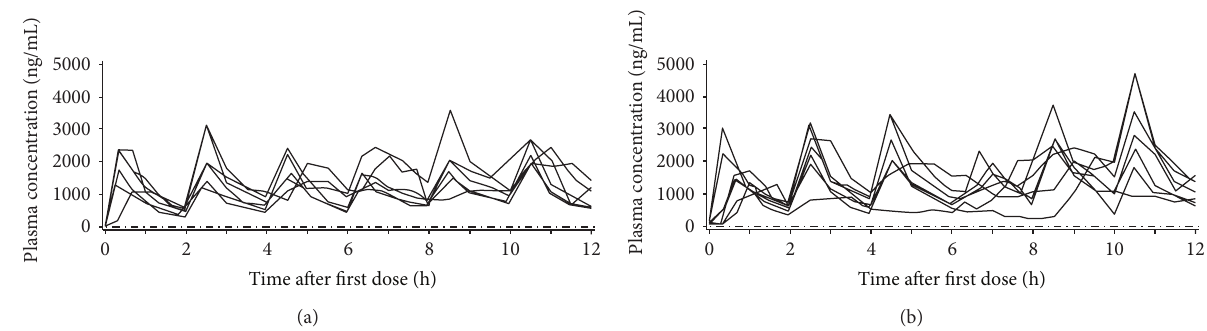
Figure 1: L-dopa plasma concentrations for patients in Cohort 1 (dose administration every 2 hours) receiving V1512 solution (a) or L- dopa/carbidopa 100/25mg standard-release tablets (b). All patients with data available for the pharmacokinetic analyses were included; patients with significant violations that may have invalidated or biased the results of the pharmacokinetic evaluations were excluded. – ⋅ – ⋅ – ⋅ = lower limit of quantification (10ng/mL).